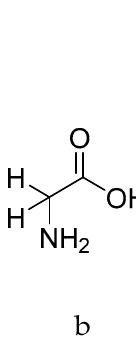
Figure 1. ( a ) depicts a general chemical structure of an amino acid; ( b ) is the structure of amino acid